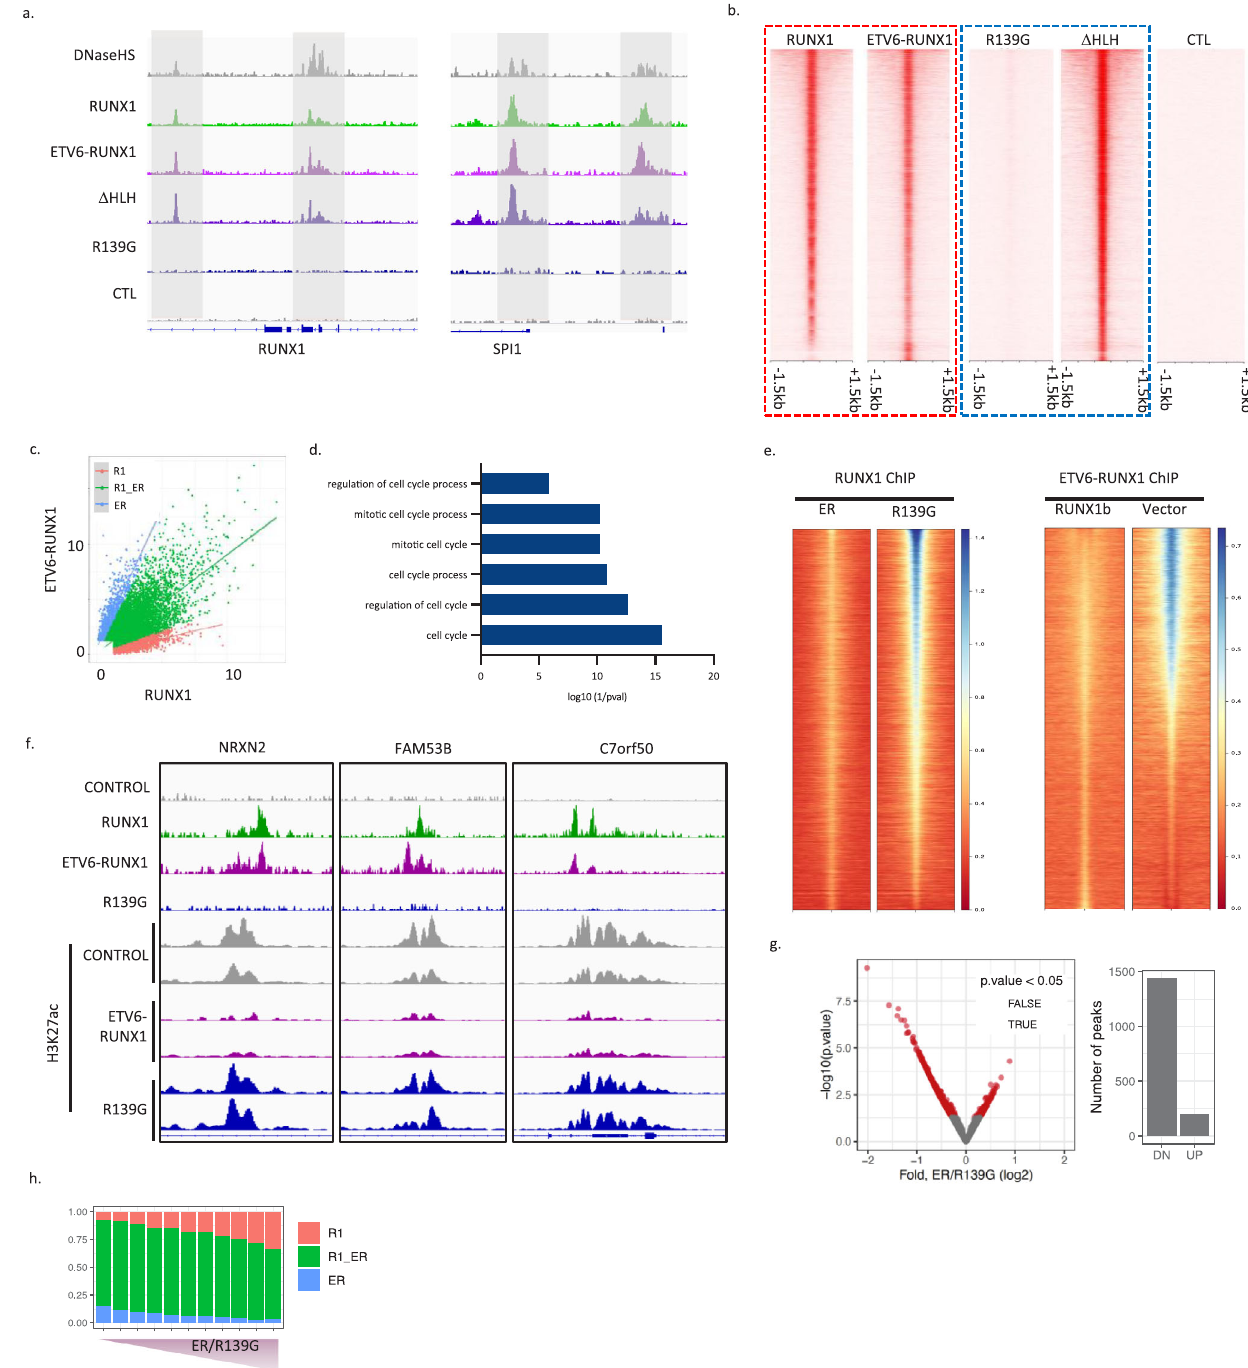
Fig. 4 | ETV6-RUNX1 binds DNA through the Runt domain, competing with native RUNX1. a Integrative Genomics Viewer (IGV) screenshots of RUNX1 and ETV6-RUNX1 binding and DNase1 hypersensitivity (DNaseHS) in NALM-6 at the RUNX1 and SPI1 loci. R139G: loss-of-function point mutation in the Runt domain of ETV6-RUNX1. Δ HLH: deletion of helix-loop-helix pointed domain of ETV6-RUNX1. CTL: V5 ChIP in NALM-6 lacking V5-tagged protein. b Heatmaps showing ChIP-seq signal across all identi fi ed RUNX1/ETV6-RUNX1 binding sites in a 3kb window centered on peak summits. c Dotplot of CPM for RUNX1 vs ETV6-RUNX1 ChIP. Colors show peaks classi fi ed as more highly bound by RUNX1 (R1), ETV6-RUNX1 (ER)orsimilarlyboundbyboth(R1_ER). d BarplotshowingenrichmentofGO-terms relatingtocellcycleingenesmappedtoR1_ERpeaksasclassi fi edin( c ). e Heatmaps showing ChIP-seq signalacrossallidenti fi ed RUNX1/ETV6-RUNX1 bindingsites in a